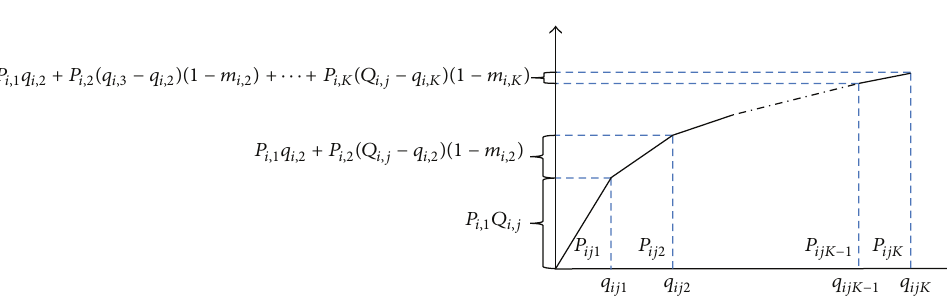
Figure 3: IQD policy for purchasing the products in different